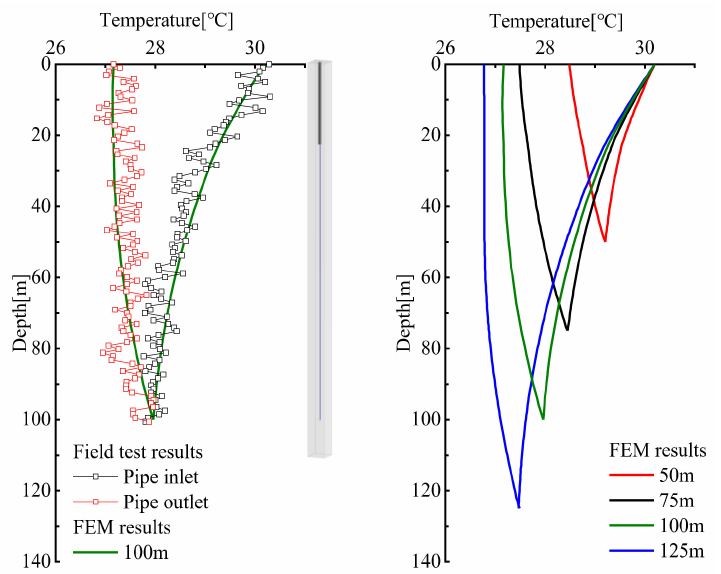
Figure 4. Temperature distribution of #1 pile heat exchange pipe along the depth direction (5.5 kW, 1.0 m 3